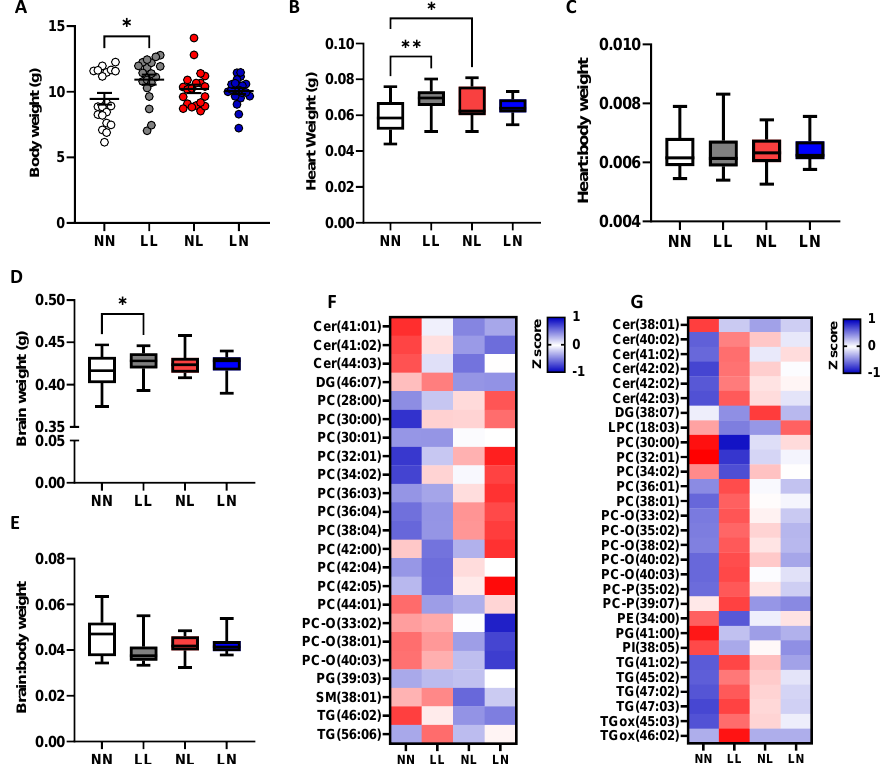
Figure 6. Impact of paternal diet on F2 neonatal offspring heart and brain tissue lipid profiles: ( A ) body weight, ( B ) heart weight, ( C ) heart:body weight ratio, ( D ) brain weight and ( E ) brain:body weight ratio of NN (NPD sperm and LPD seminal plasma), LL (LPD sperm and LPD seminal plasma), NL (NPD sperm and LPD seminal plasma) and LN (LPD sperm and NPD seminal plasma) F2 offspring at 3 weeks of age. Z-scores of differential lipids between NN, LL, NL and LN offspring ( F ) cerebellum and ( G ) cerebrum. N = 10 – 20 offspring (5 – 10 males and females) per treatment group, sampled from all litters generated. Data are expressed as mean ± SEM ( A - D ). * p < 0.05, ** p < 0.01. Statistical differences were determined using a random effects regression analysis ( A - D ) or one-way ANOVA with Bonferroni post hoc correction ( E , F ).